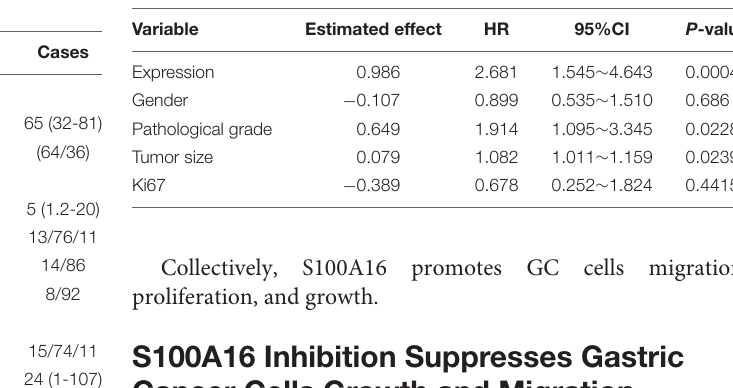
TABLE 3 | Multivariate Cox regression fitting